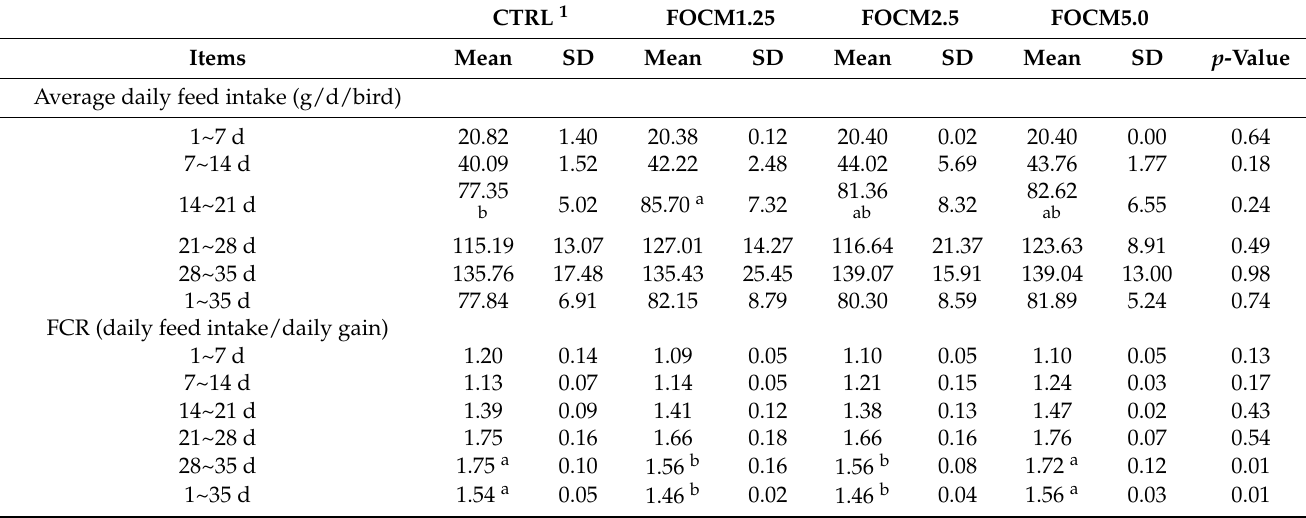
Table 3. Effect of FOCM supplemented in diet on average daily feed intake and feed conversion rate in broilers. CTRL 1 FOCM1.25 FOCM2.5 FOCM5.0